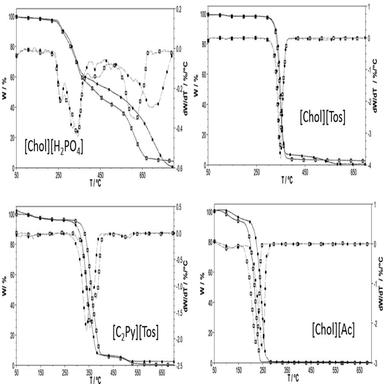
Dynamic TG (solid) and DTG (dashed) curves of the selected ILs obtained at 10 C min1 under air () and N2 (h) atmospheres.